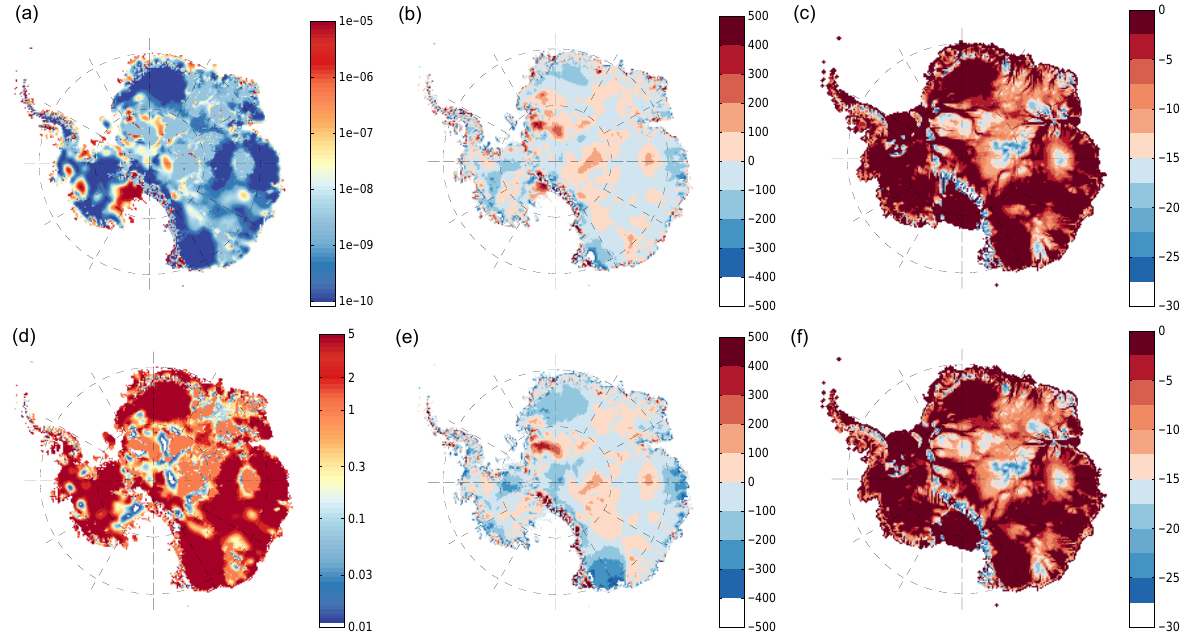
(x,y) after 80000 years of integration (left); difference between optimized and Figure 4. Top row: optimized basal sliding coefficients A (cid:63) b observed surface elevation (centre); basal temperature relative to pressure melting point (right). Bottom row: similar to top row but with (x,y) according to the Coulomb friction optimized friction coefficients O (cid:63) b